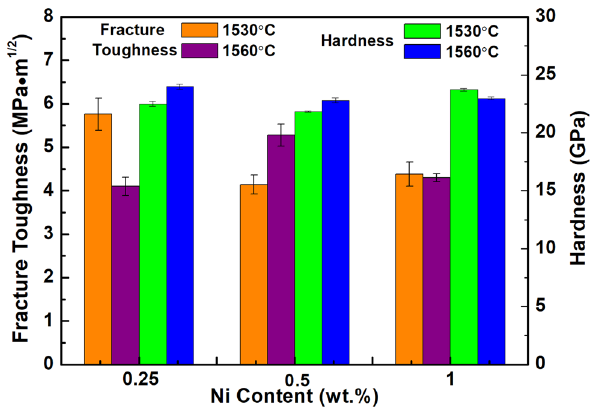
Figure 8: Hardness and fracture toughness of each specimen of WC – Ni composite ceramics.